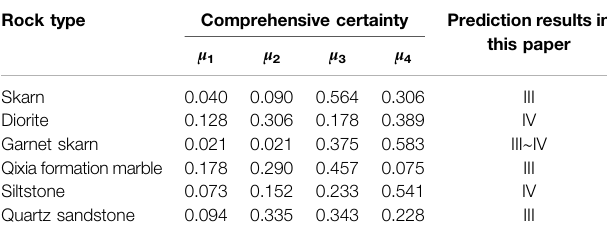
TABLE 10 | Rock burst tendency prediction results for the Dongguashan Copper Mine. Rock